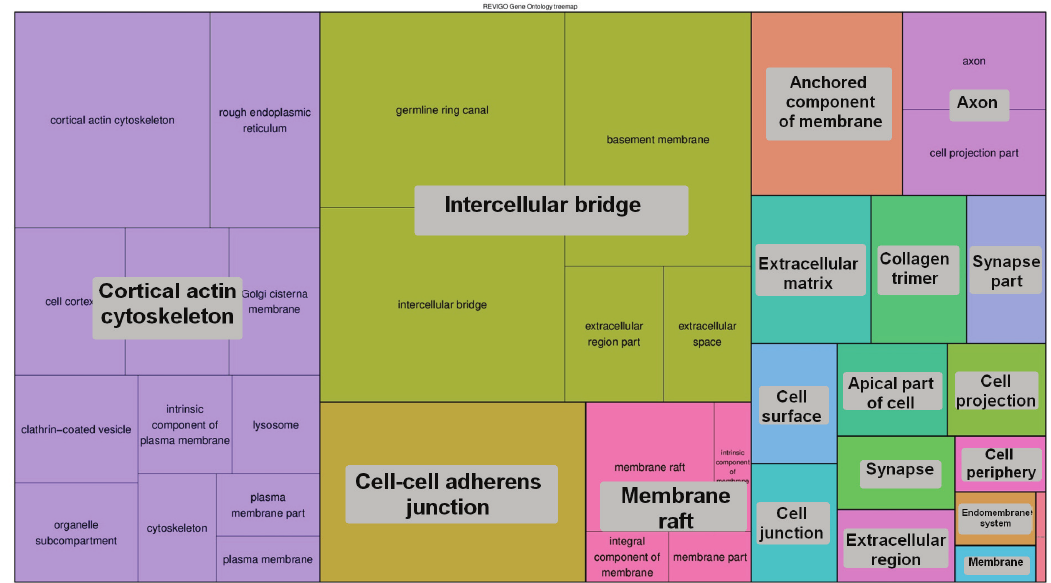
Figure 7. The GO terms (cellular components) that were enriched for genes prone to 5-hmC modification. The areas of rectangles are proportional to the relative increase in frequency of GO terms comparing genes that had 5-hmC-related peaks to genes that completely lacked them. The corresponding quantitative data and a full list of GO terms can be found in Supplementary File S3.